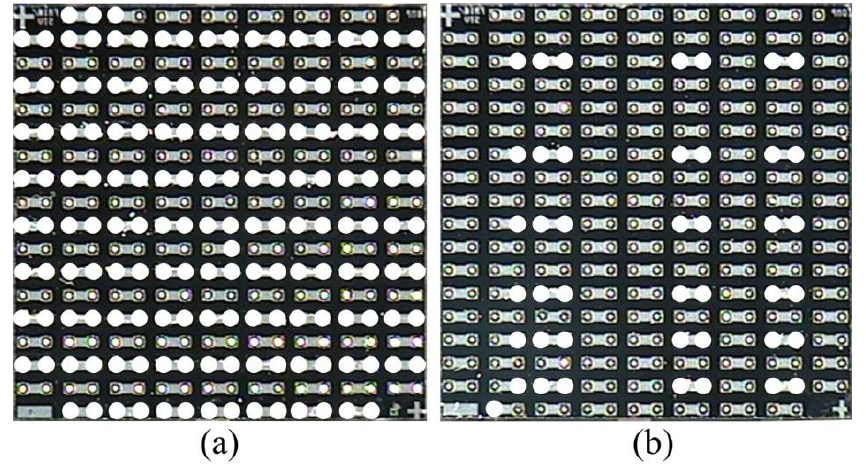
Figure 3. The optical images of the flip chip specimens.